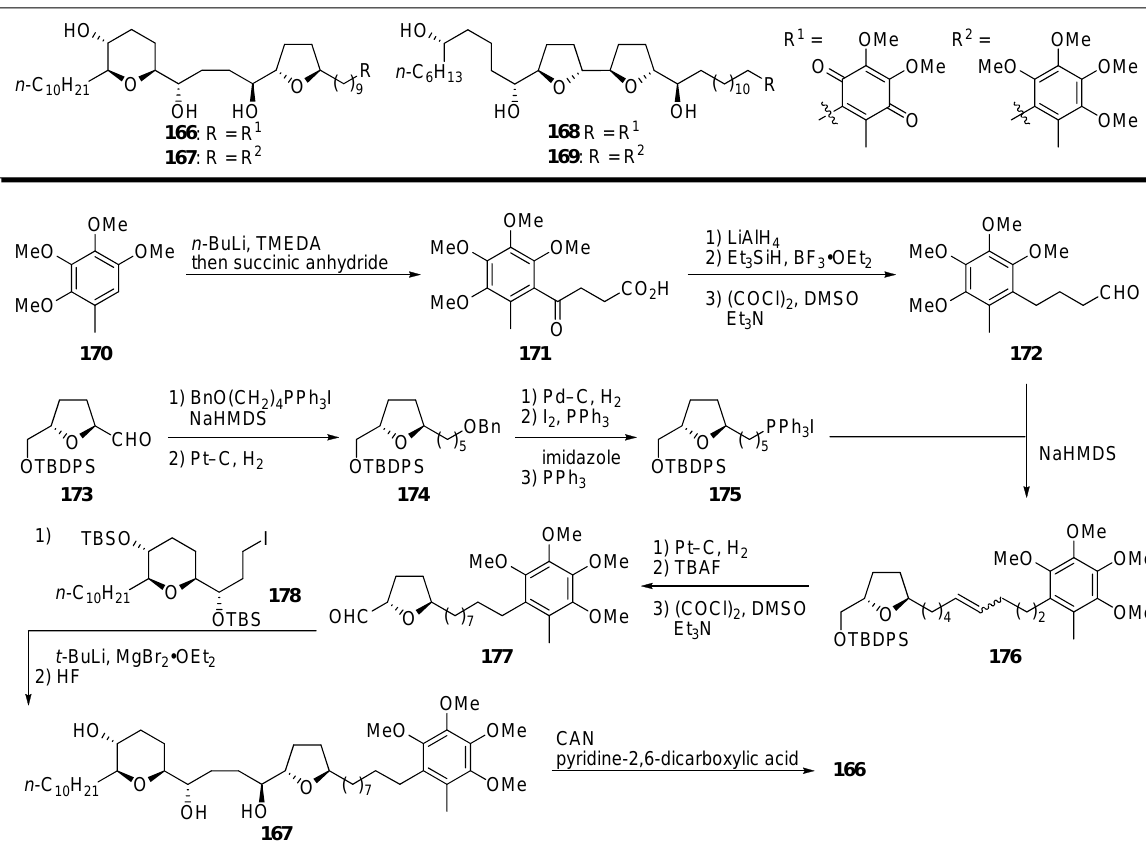
Scheme 12. Synthesis of quinone analogues by Koert’s group.